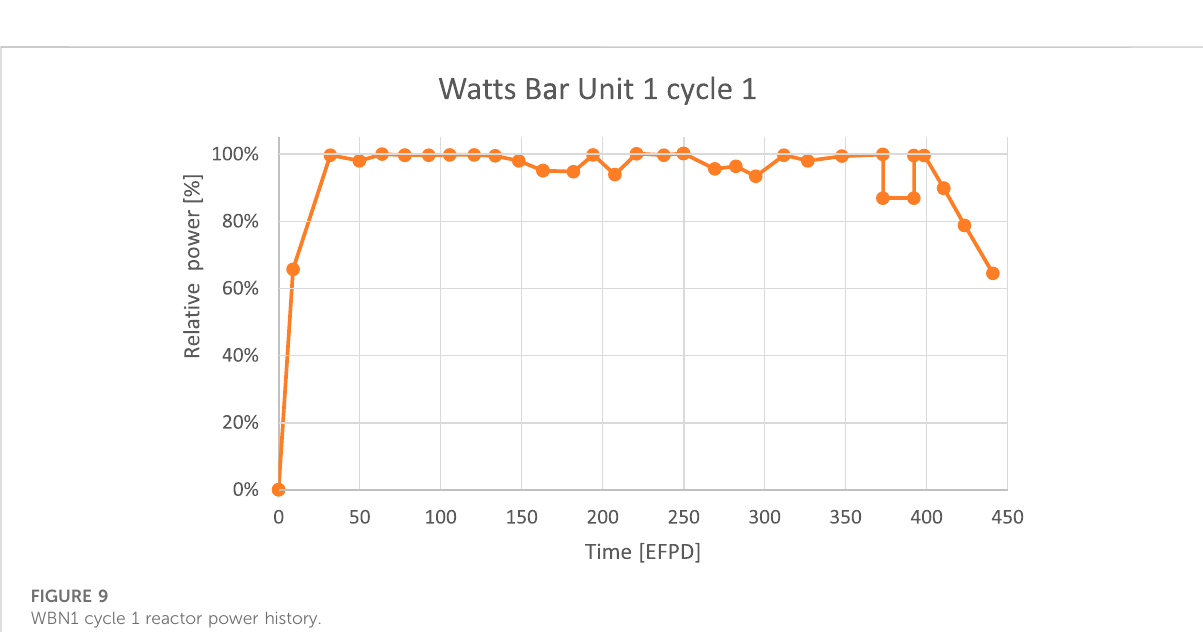
WBN1 cycle 1 reactor power